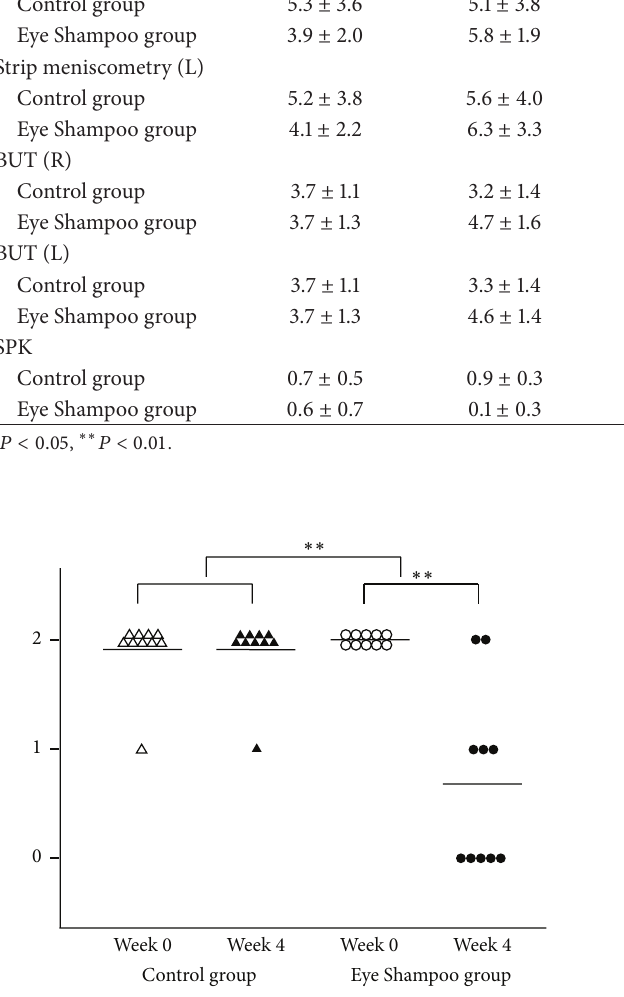
Figure 5: Meibum secretion in the two groups, evaluated by pressing the middle of the upper eyelid with a thumb. 0, expression with mild pressure; 1, expression with moderate pressure; 2, no expression with moderate